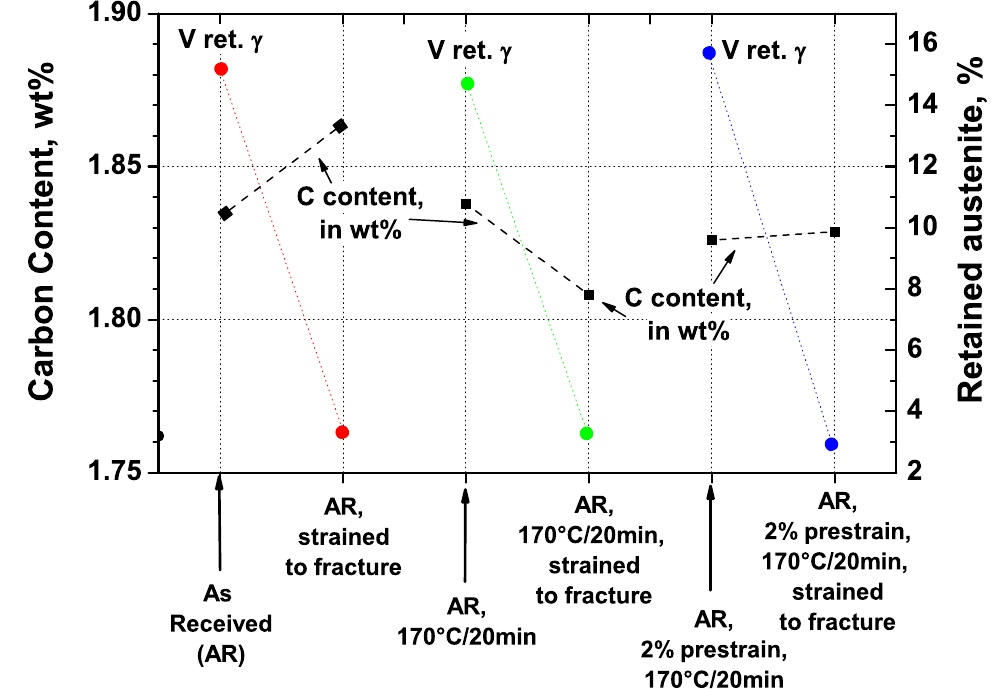
Figure 13. Evolution of the carbon content and retained austenite in the different samples mybluefor the TRIP5